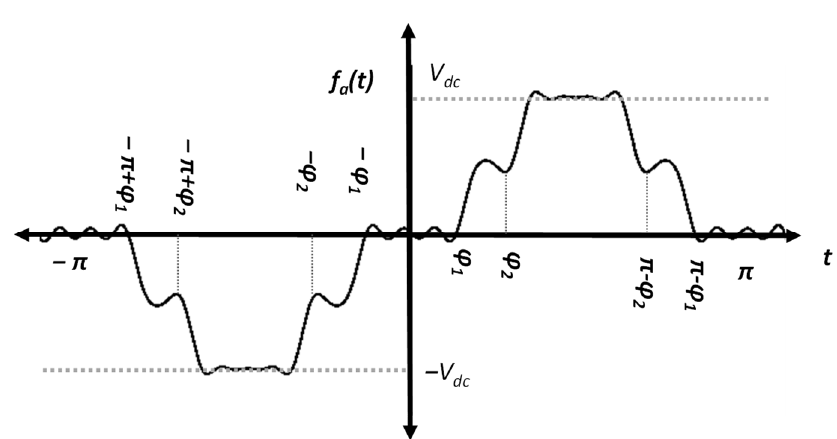
Figure 6. The mathematical representation of a 7-level inverter output voltage is given in Equation (6).